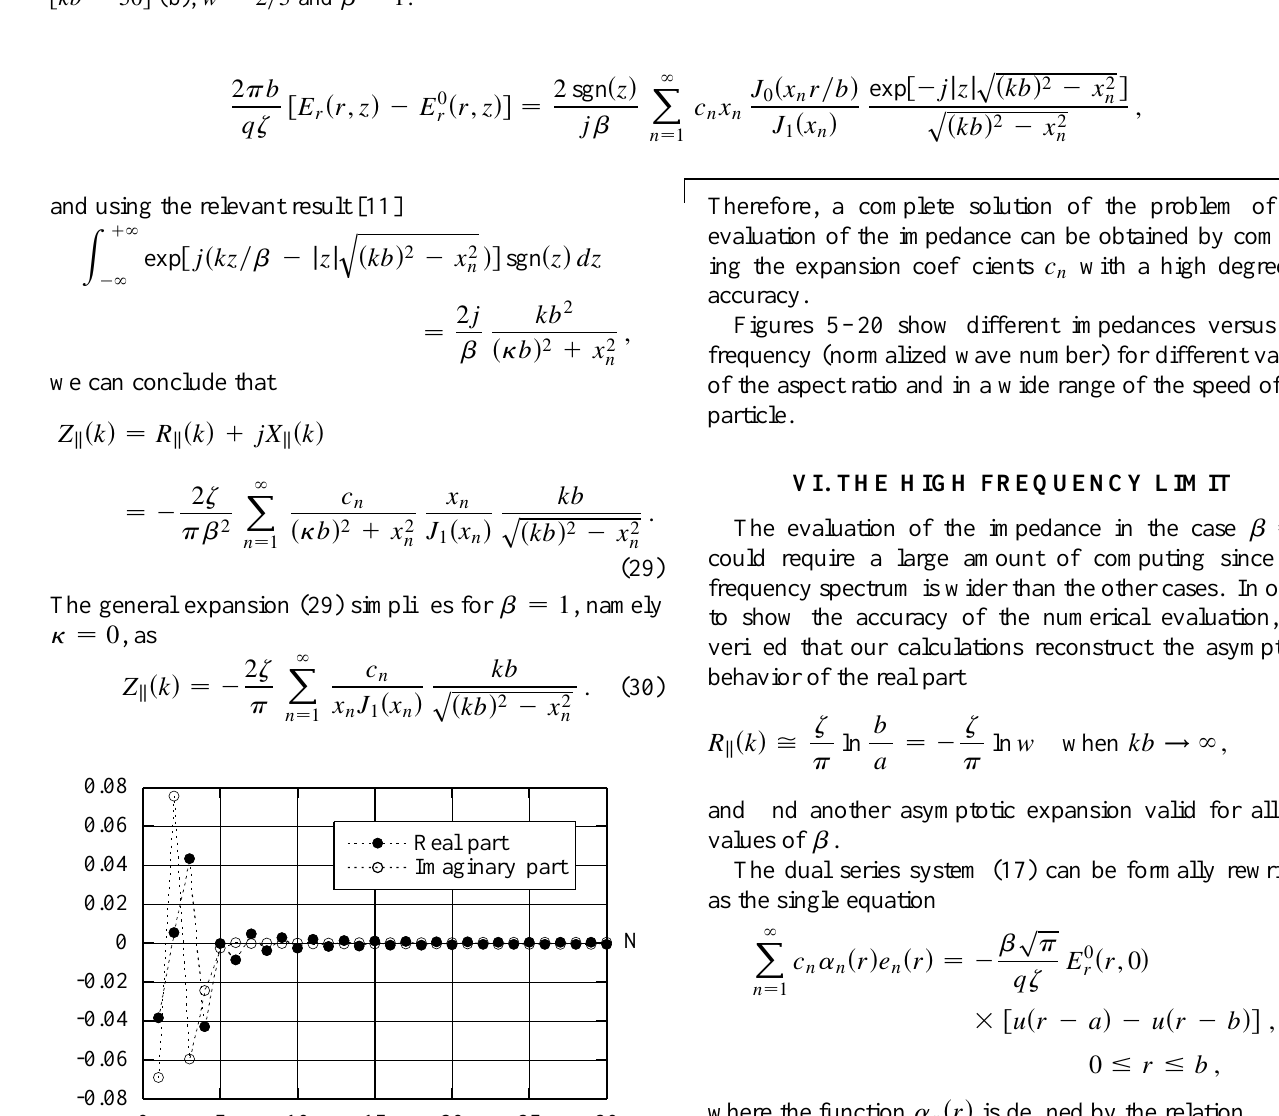
FIG. 3. The coefficient matrix (main diagonal and first parallel) for a small value of (cid:107)(cid:98) (cid:102) (cid:107)(cid:98) (cid:173) (cid:49) (cid:121) (cid:49)(cid:48) (cid:103) (a) and for a large one (cid:102) (cid:107)(cid:98) (cid:173) (cid:53)(cid:48) (cid:103) (b), (cid:119) (cid:173) (cid:50) (cid:121) (cid:53) and b (cid:173) (cid:49) .